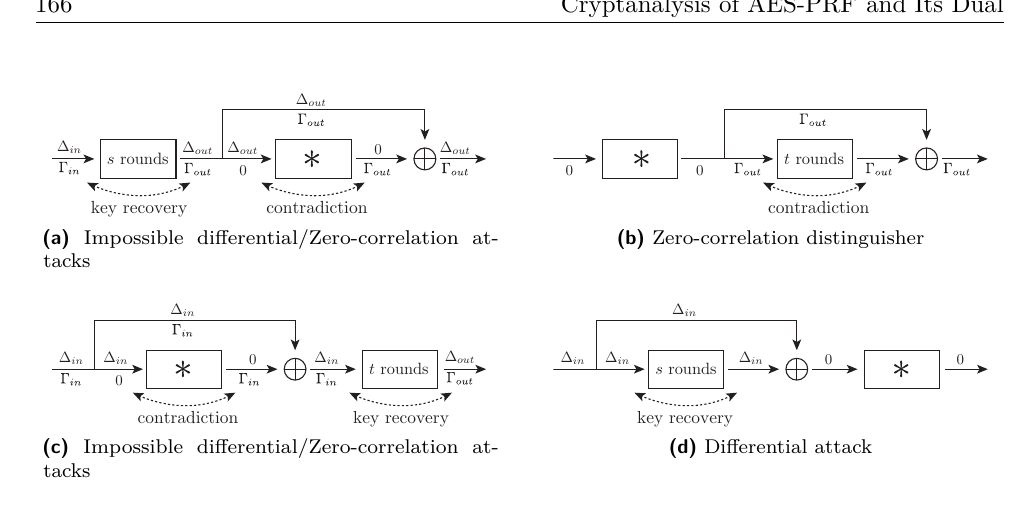
Figure 5: Summary of attacks, where either of the first or last sub-block can be regarded a random